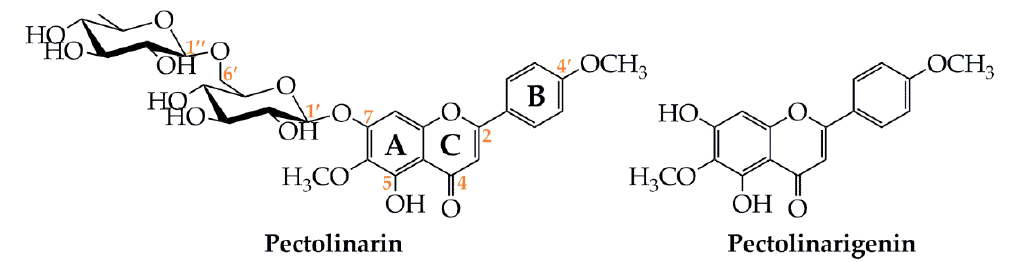
Figure 1. Molecular structures of pectolinarin and pectolinarigenin.